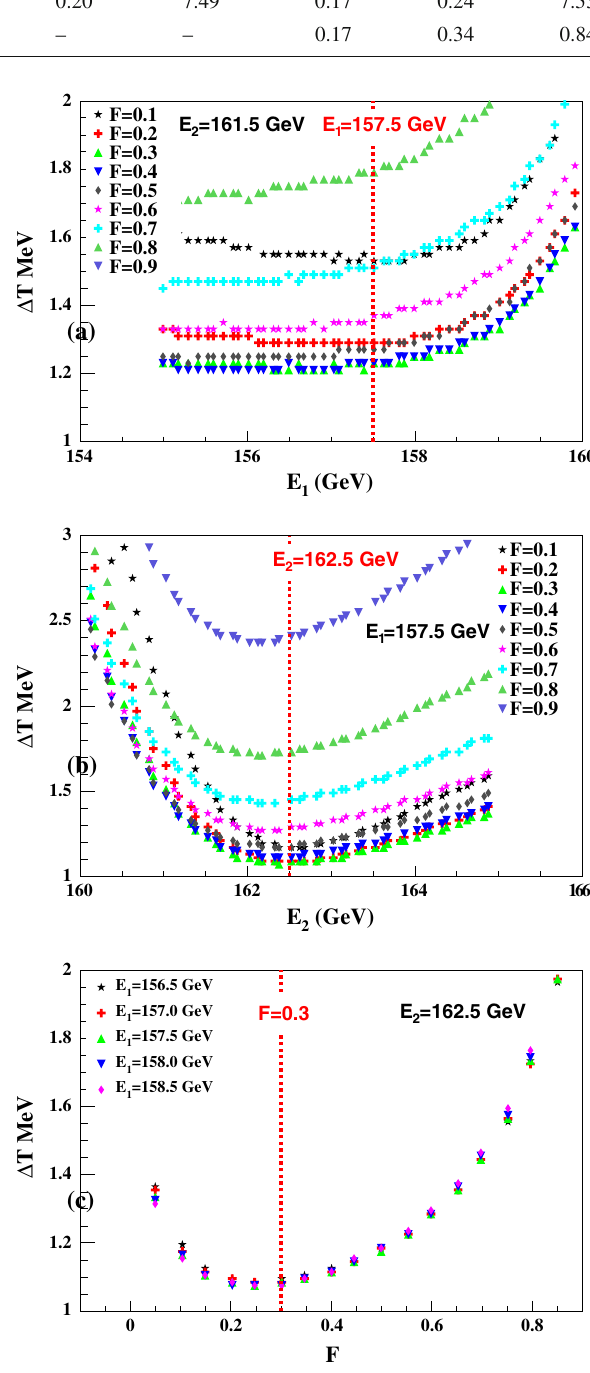
Fig. 11 The optimization results of 3D scan for taking data at two points. (a)-(c) are for E 1 , E 2 , and F , respectively. In practice, each parameter is optimized by scanning other two parameters. These three plots just shows the dependence of Δ T on one parameter, with another one float and the third one